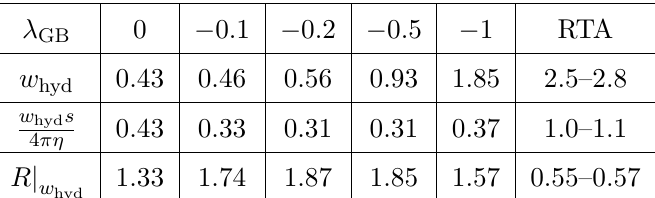
Table 1 . Inverse gradient size and anisotropy function at hydrodynamization for di(cid:11)erent theories. Note that for RTA the quoted range re(cid:13)ects the sensitivity of the resummation to Pad(cid:19)e order and does not include the uncertainty associated with the imaginary part of the inverse Borel